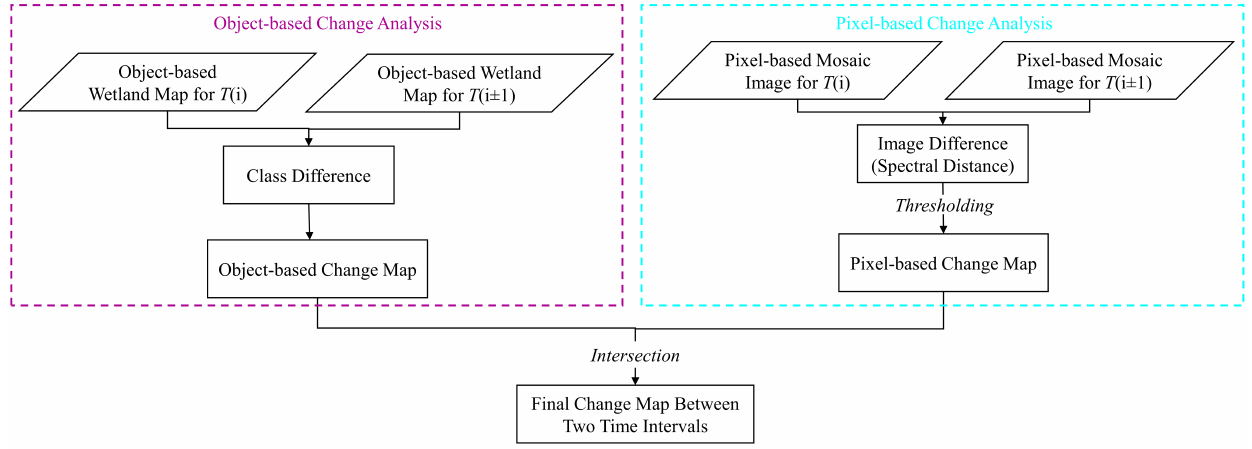
Figure 5. The method for wetland Change Detection (CD) between two time intervals, where T indicates the time interval (see Table